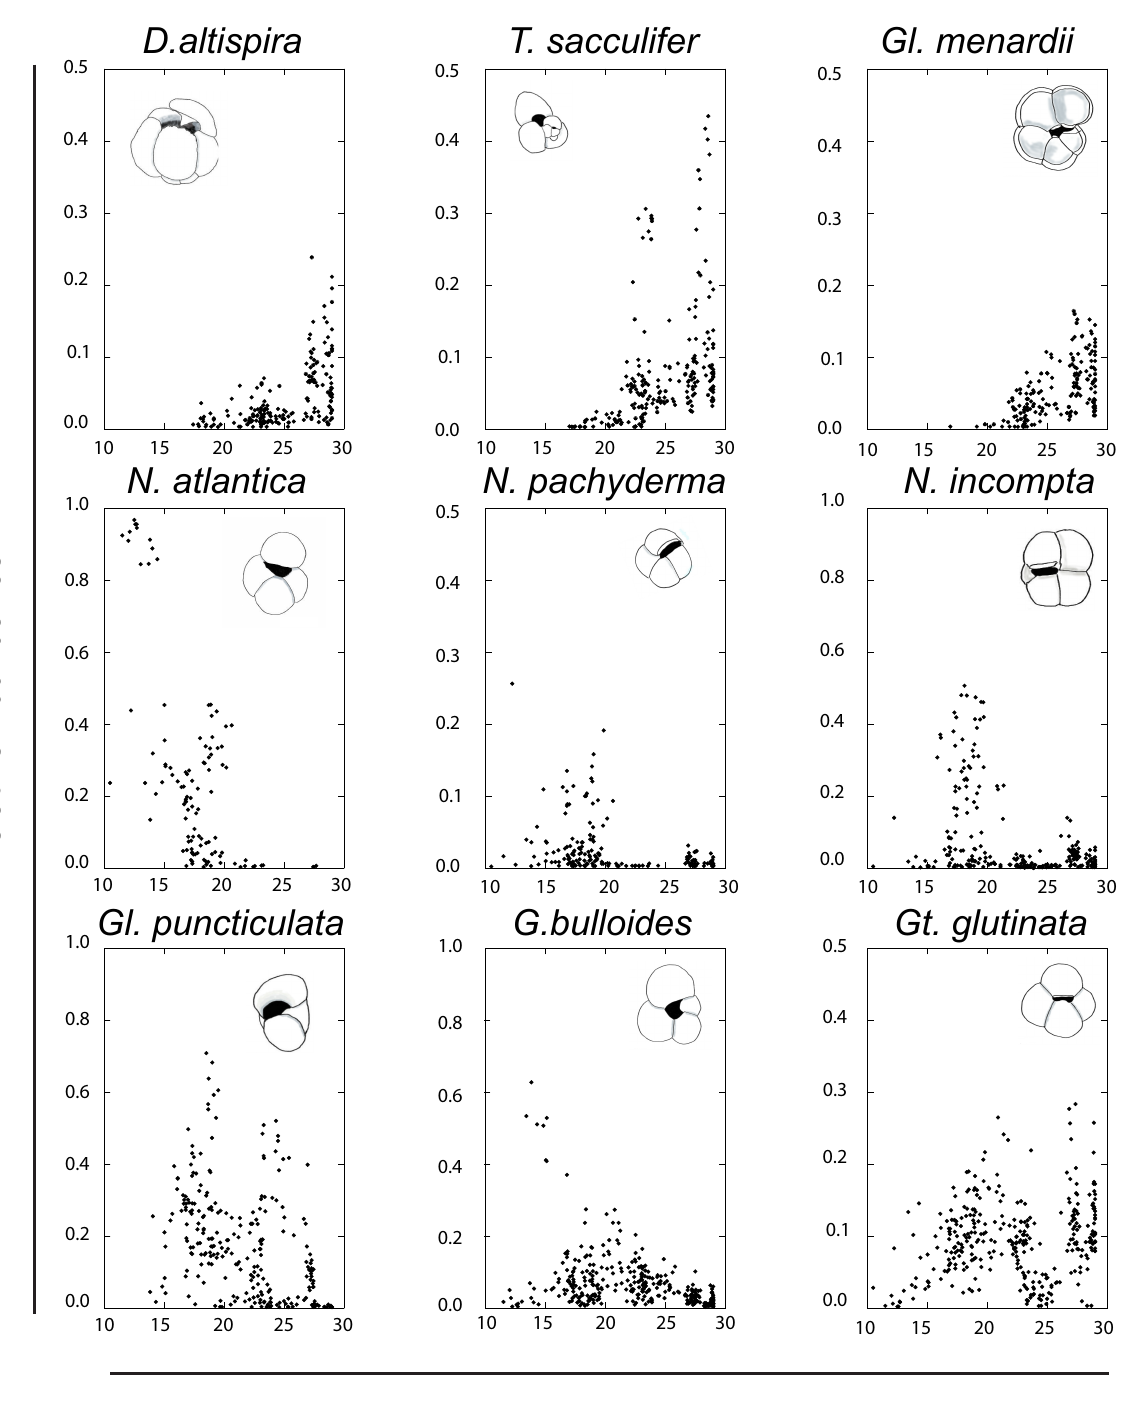
Figure 2. Temperature responses of nine species of Pliocene planktic foraminifera found in the North Atlantic. Sea surface temperatures derived using the U K (cid:48) index range from 10 ◦ C to 30 ◦ C and are 37 plotted against the relative abundance of species (0.0 to 1.0) within each sample. See